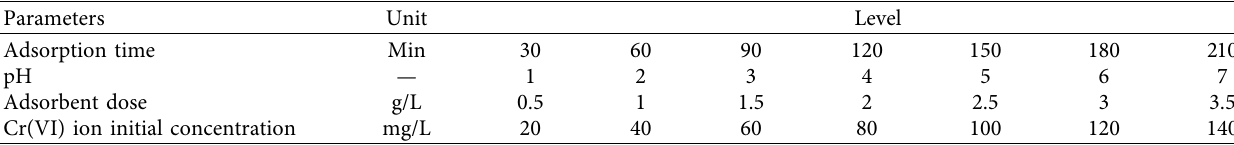
Table 1: Parameters and their levels for OVAT